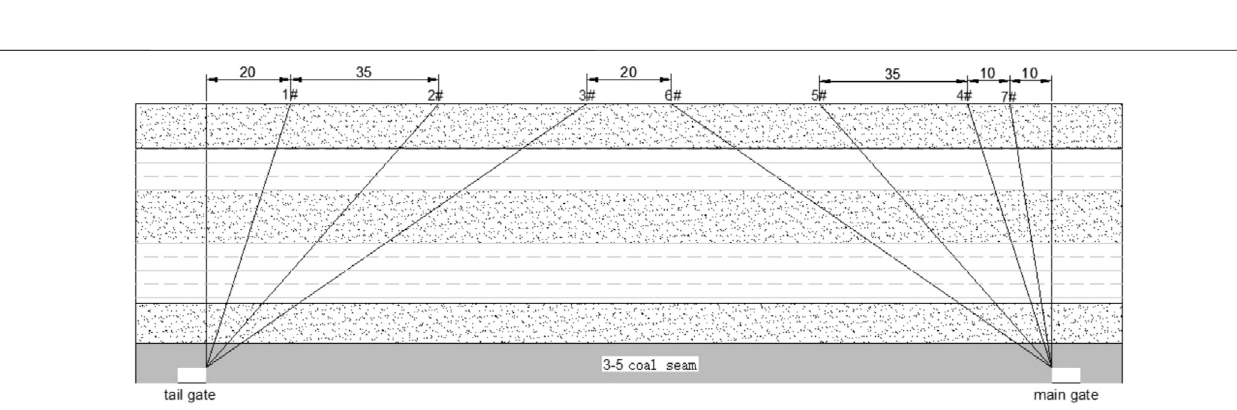
FIGURE 11 | Layout parameters of roof pre-split blasting